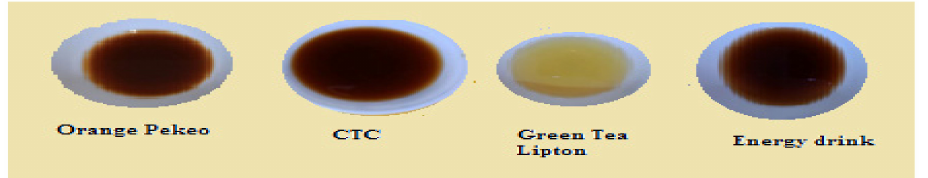
Figure 13. Tea infusion (Set 1–10 g, 5 min, 100 mL).